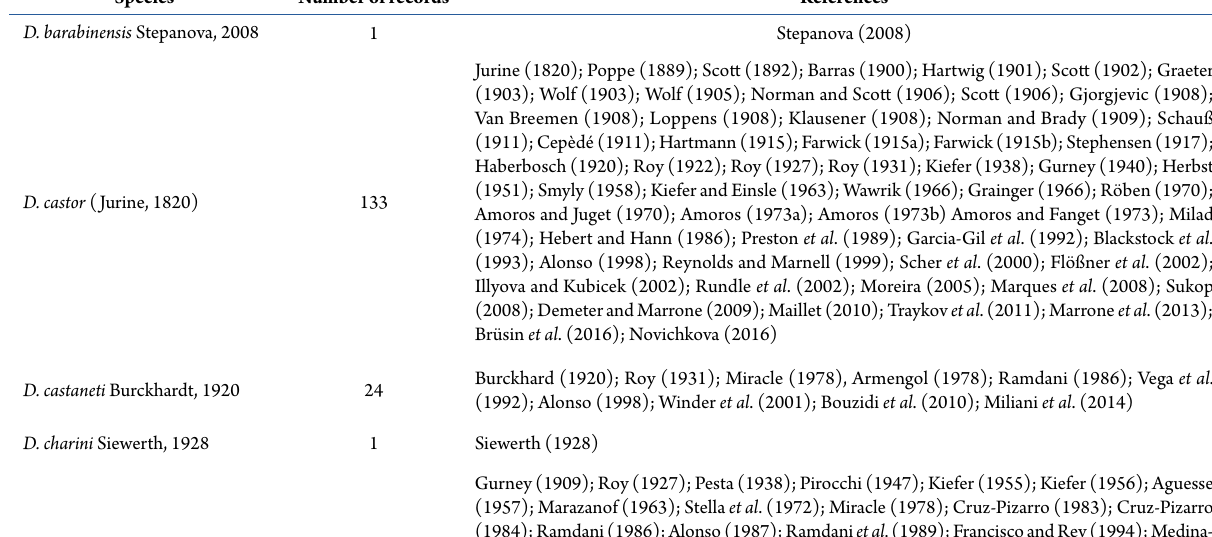
Table 1. Species of Diaptomus included in this study and number of occurrence records and respectives references for each one. Species Number of